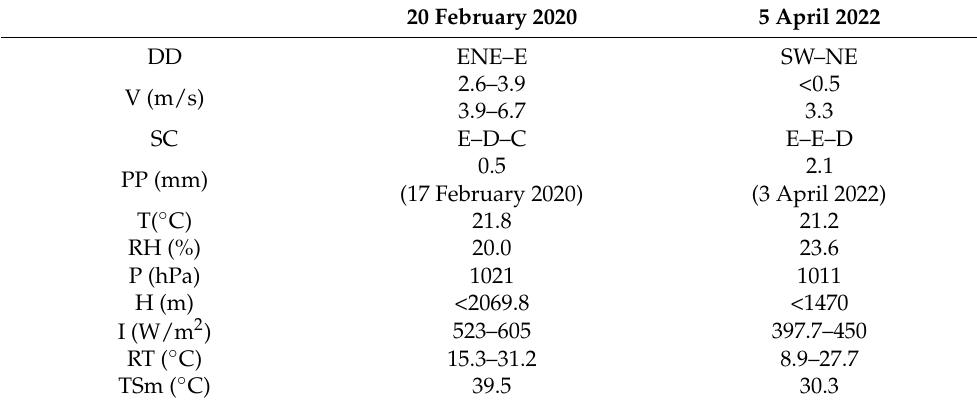
Table 2. Mean meteorological parameters during the field experiments at LPR (15 UTC to 18 UTC). Rainfall (PP, mm), relative humidity (RH, %), evolution of atmospheric stability (SC, [36], wind speed (v, m/s), wind direction (DD), mean air temperature (T, ◦ C), height of the mixed layer (H, m), atmospheric pressure (P, hPa), downward shortwave radiation range (I, W/m 2 ), temperature range on the 3 days prior to the sampling (RT, ◦ C), 3-hourly soil moisture during the sampling period (RTS, ◦ C) (source: NOAA Air Resources Laboratory). Rainfall corresponds to days 17 February 2020 and